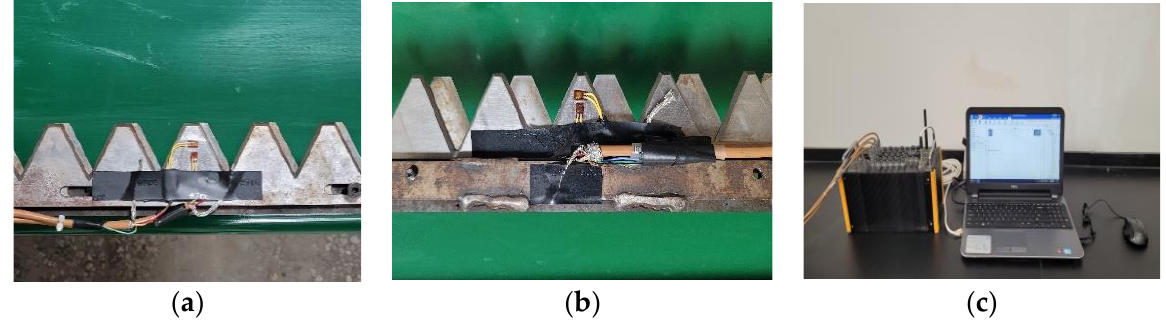
Figure 7. Schematic diagram of arrangement and wiring of strain gauge: ( a ) installation locations of the strain gauges on the upper blade; ( b ) installation locations of strain gauges on the bottom blade; ( c ) wire connection between the data acquisition instrument and computer.